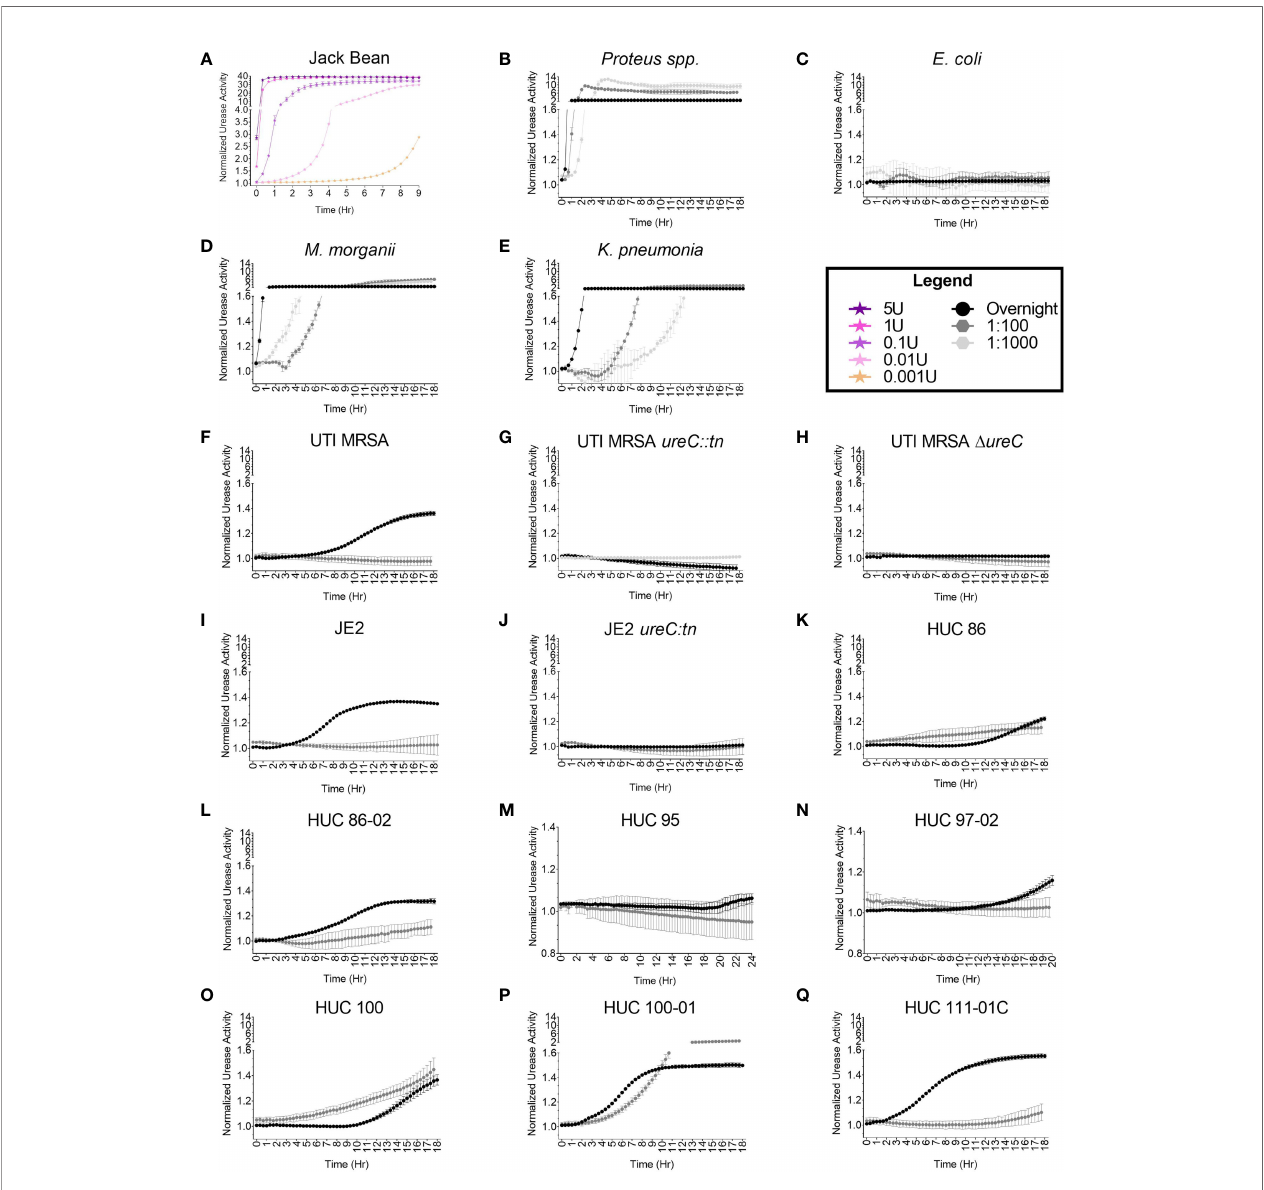
FIGURE 4 | High throughput, semi-quantitative urease activity detection assay. The urease activity detection assay was validated with (A) Jack Bean enzyme, (B) Proteus spp., and (C) Escherichia coli. A dose response curve (5U, 1U, 0.1U, and 0.001U) of Jack Bean urease was assessed. Enzymatic activity was detected immediately for 5U and 1U, at 20 minutes for 0.1U, at 40 minutes for 0.01U, and at 4 hours for 0.001U. For the bacterial strains, increasing concentrations of bacteria were assessed including 1:1000 and 1:100 dilutions of overnight cultures, as well as overnight cultures resuspended in urease broth, with urease activity detected at 1.5 hours, 40 minutes, and 20 minutes for the Proteus spp. strain, respectively. The E coli strain did not display urease activity. Additional, diverse urease-producing uropathogens at 1:1000 and 1:100 dilutions of overnight cultures, as well as overnight cultures resuspended in urease broth were assessed for urease activity, including (D) Morganella morganii detected at 3 hours, 40 minutes, and 20 minutes, respectively; and (E) Klebsiella pneumonia detected at 4, 4, and 0.5 hours, respectively. For S. aureus strains urease activity was assessed at 1:100 dilutions of overnight cultures, as well as overnight cultures resuspended in urease broth, with (F) UTI MRSA detected at 4 hours only at the highest bacterial concentration (overnight suspension). The (G) UTI MRSA ureC::tn and (H) UTI MRSA D ureC , were used as negative controls. No urease was detected over the course of the 18-hour experiment. Furthermore, (I) JE2 urease was detected at 4 hours only in the highest bacterial concentration tested (overnight suspension), while no urease was detected for (J) JE2 ureC::tn across the course of the 18-hour experiment. Lastly, additional S. aureus strains were assessed for urease activity to determine the assay ’ s accuracy in detecting variable urease producers. Urease activity was detected for (K) HUC 86 at 10 hours and 3 hours for the 1:100 dilution and overnight culture suspension, respectively; (L) HUC 86-02 at 6 hours and 2 hours for the 1:100 and overnight suspension, respectively; (M) HUC 95 at 20 hours only in overnight suspensions; (N) HUC 97-02 at 12 hours only in overnight suspensions; (O) HUC 100 at 10 hours and 3 hours for the 1:100 dilution and overnight suspension, respectively; (P) HUC 100-01 at 4 hours and 1.5 hours for the 1:100 dilution and overnight suspension, respectively; and (Q) HUC 111-01C at 12 hours and 0.5 hour for the 1:100 dilution and overnight suspension, respectively. Points represent the mean of three technical replicates and two biological replicates and error bars represent standard deviation from the